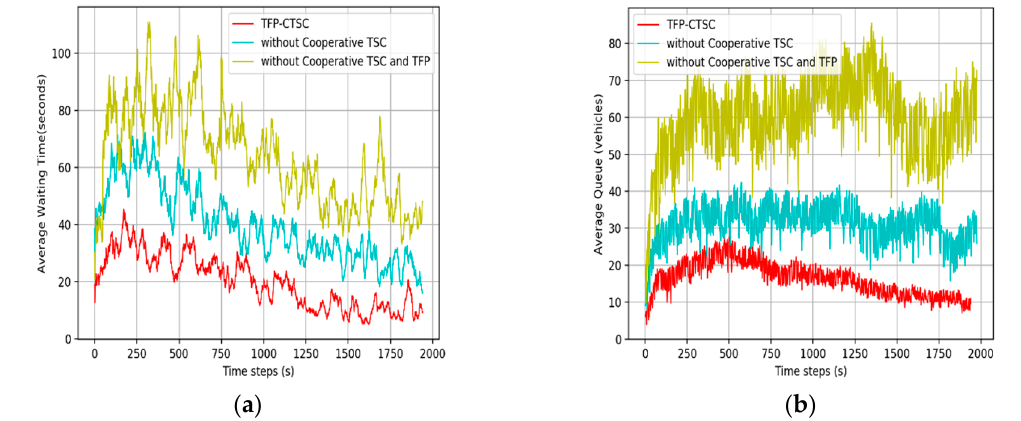
Figure 10. Performance comparison with TFP-CTSC without CTSC and TFP. ( a ) Average waiting time; ( b ) queue length.